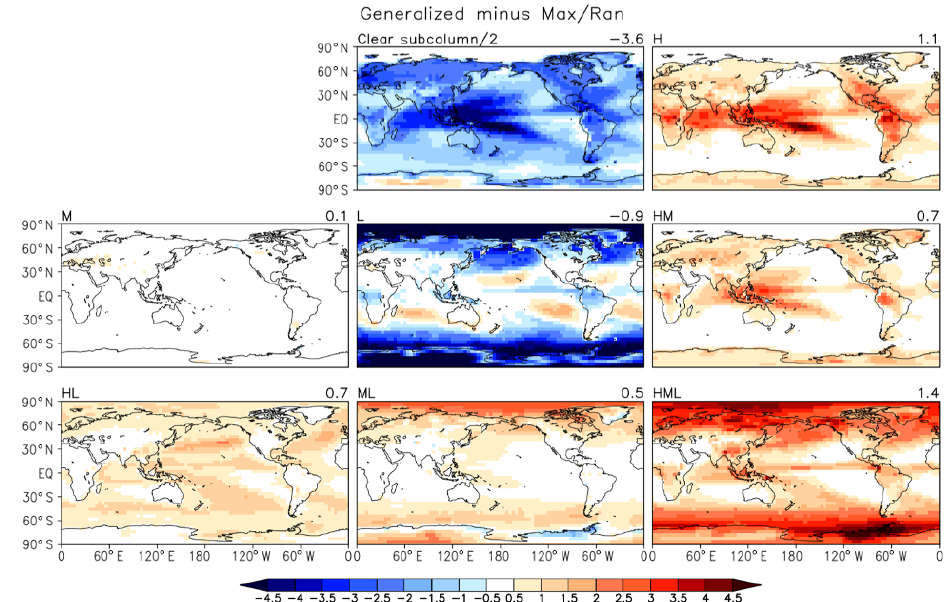
Figure 3. RFO difference (%) maps for clear skies (divided by two to use a common color scale) and the seven CVS classes as simulated by GEOS-5 using the GN and MR overlap assumptions in the cloudy subcolumn